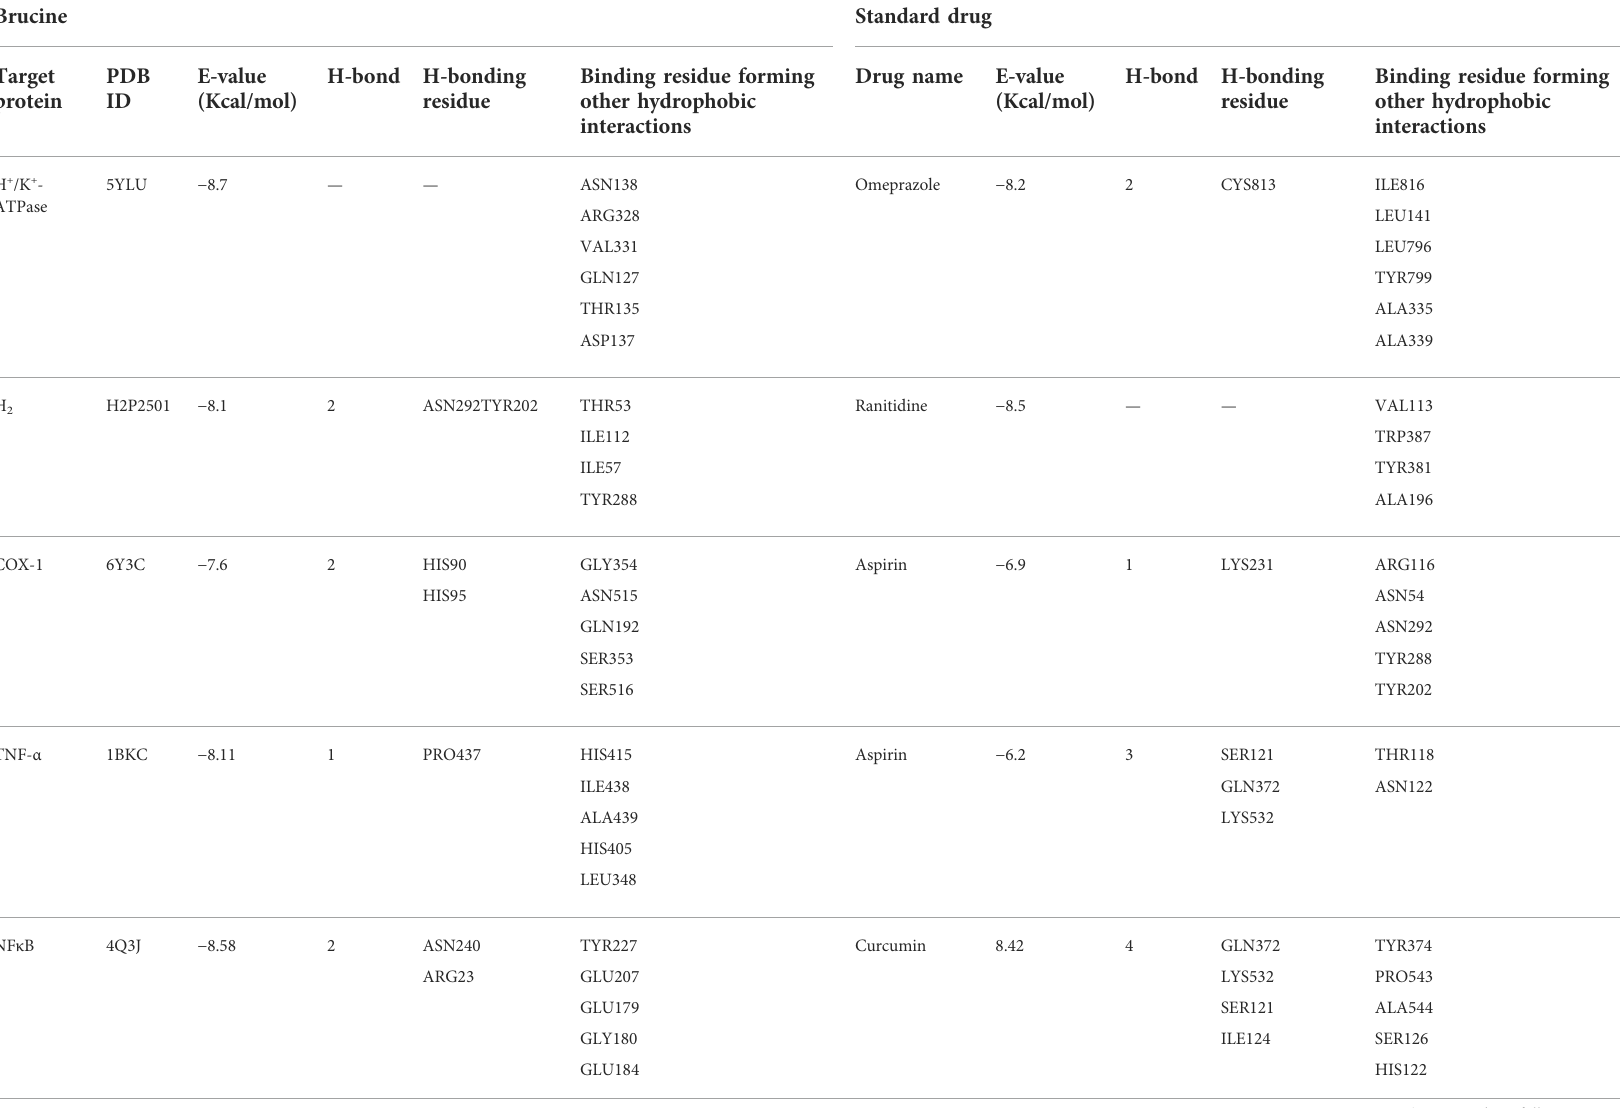
TABLE 1 Binding energy (kcal/mol) and post-dock analysis of the best conformational pose of brucine with H + /K + -ATPase, histaminergic (H 2 ) receptor, cyclooxygenase (COX-1), tumor necrosis factor (TNF- α ), nuclear factor kappa B (NF κ B), prostaglandin (PGE 2 ), cyclooxygenase (COX-2), and muscarinic (M 1 )